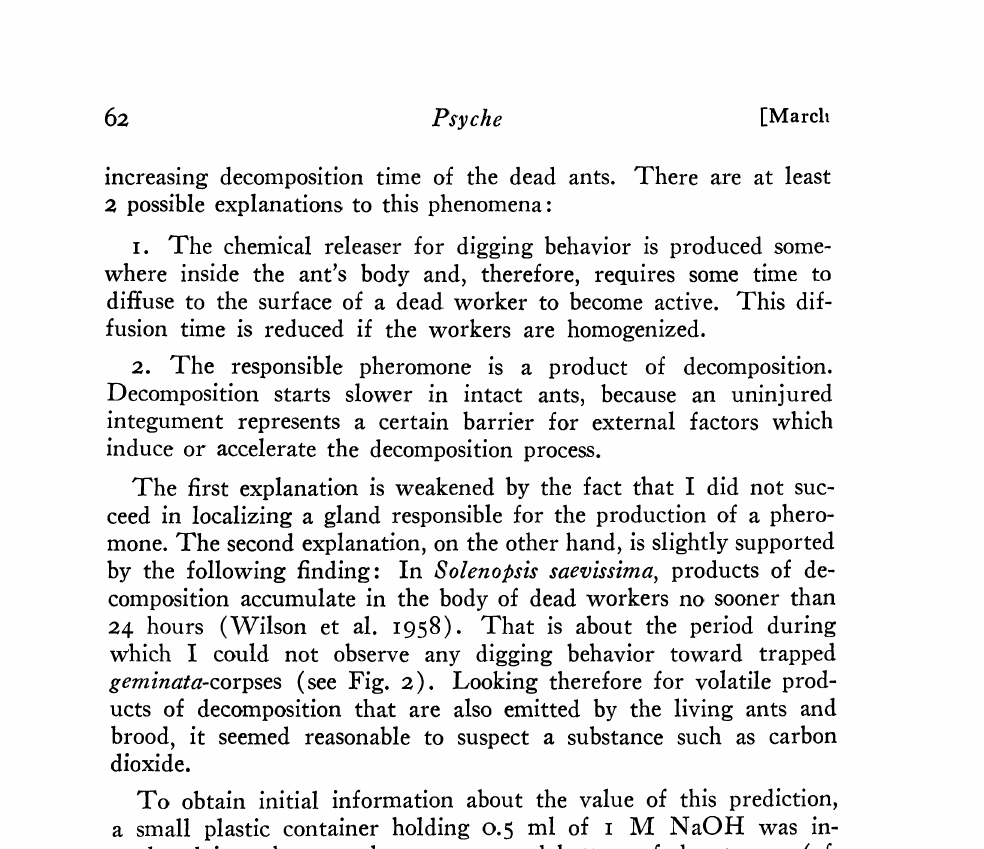
Table 2. Effect of Na,OH on the digging behavior o ants toward trapped nestmates. Number of repetitions: